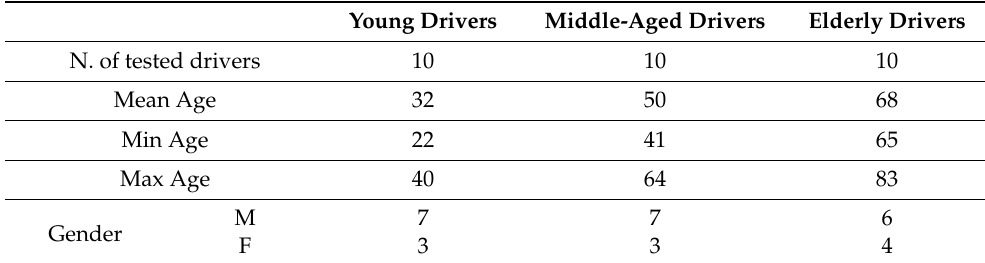
Table 1. Characteristics of the sample.